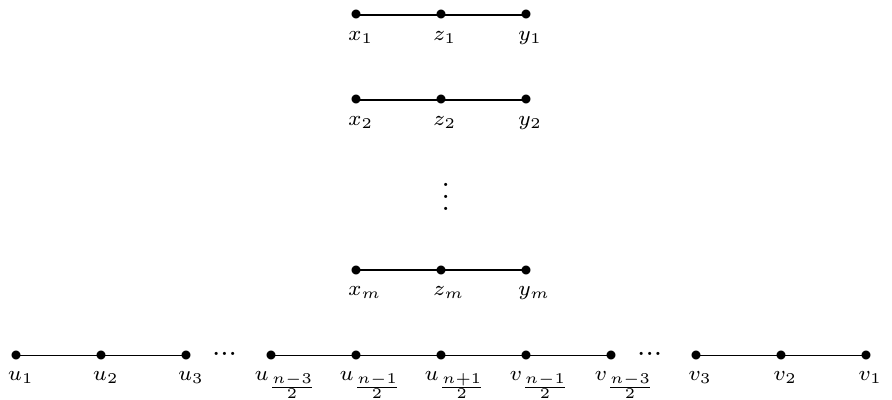
P n with an odd integer n (cid:83)